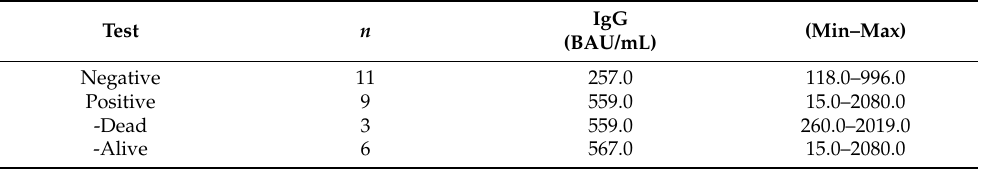
Table 6. Anti-SARS-CoV-2 IgG testing of the 20 guests vaccinated with the BNT162b2 mRNA COVID-19 vaccine (Comirnaty). The serological test is considered positive if IgG ≥ 33.8